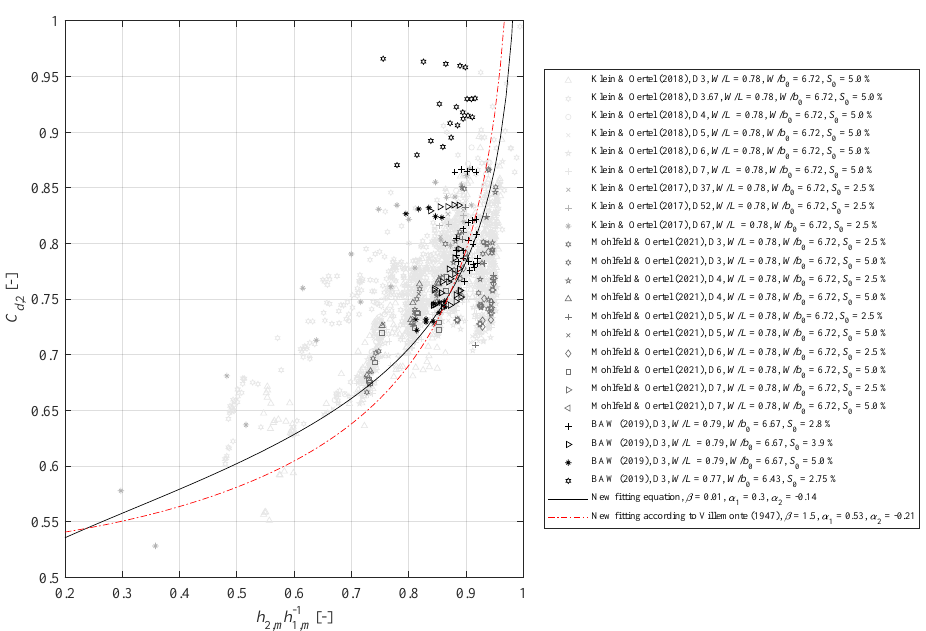
Figure 7. Discharge coefficients and new fitting equations according to Equation (3) based on Torricelli (Equation (8)) [3,6,23,25].